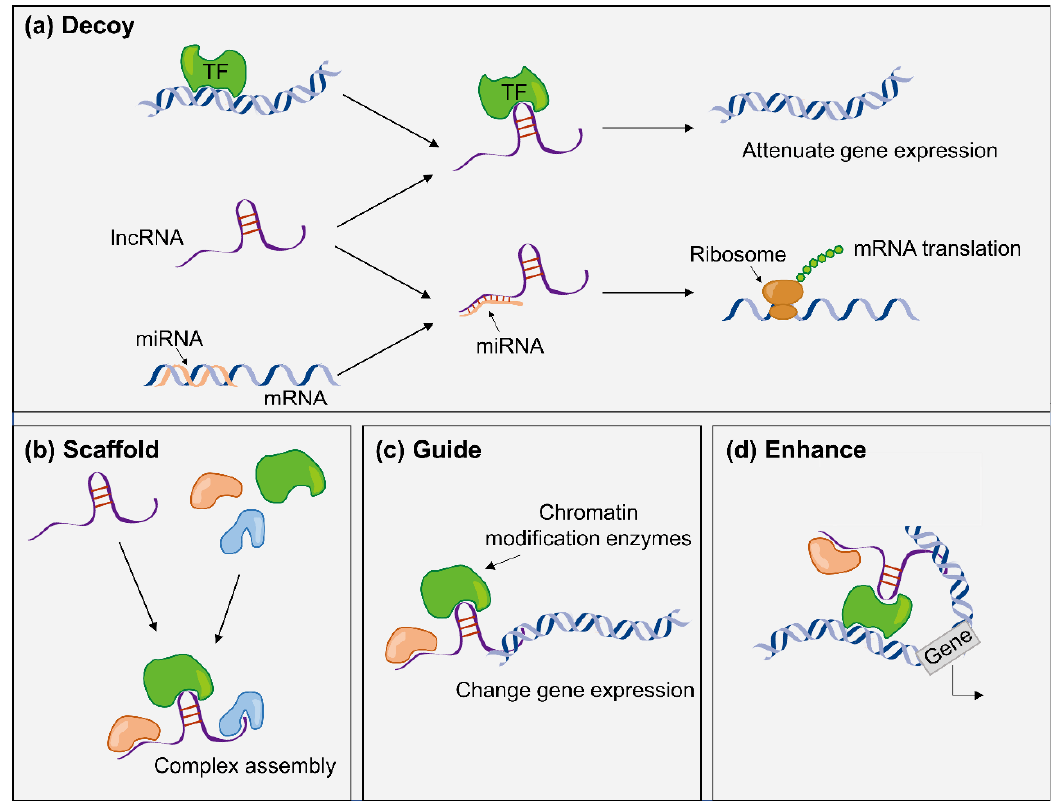
Figure 2. Models of lncRNA mechanisms of action. ( a ) lncRNAs may act as decoys to lead transcription factors (TFs) away from DNA targets or directly bind to sequester complementary RNA transcripts, such as miRNAs (also known as competing endogenous RNAs or “sponges” of miRNAs). The effect of this biological function is to regulate the expression of the genes and the translation of the mRNA. ( b ) lncRNAs may act as scaffolds to assemble two or more proteins into a complex. ( c ) lncRNAs may act as guides to regulate gene expression by recruiting proteins, such as chromatin modification enzymes. ( d ) lncRNAs may act as enhancers in chromosome looping (also known as cis ‐ regulatory elements) [24].